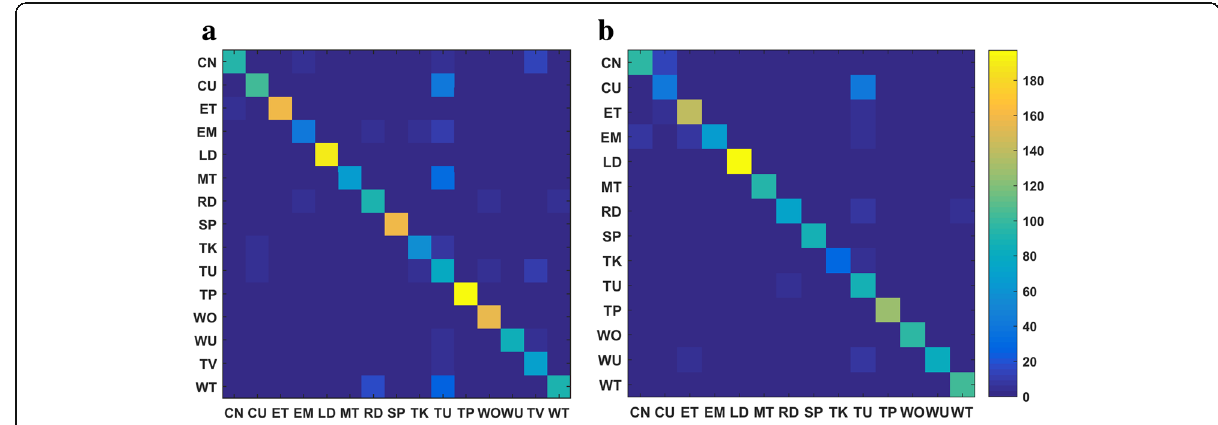
Fig. 8 Confusion matrices for the fusion results obtained by 2-L HFNDCS as applied to a wearer 1 and b wearer